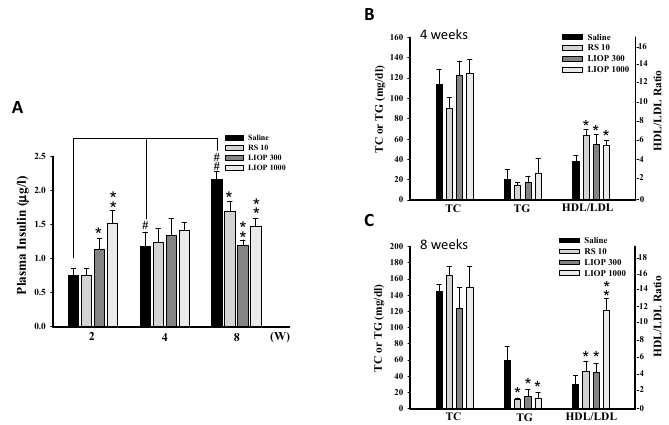
Figure 4. Plasma insulin levels and serum lipid profile. Blood samples were collected from the retro-orbital sinus of C57BL/6 mice with HFD + STZ-induced diabetic nephropathy. The plasma insulin levels were measured by ELISA at two, four, and eight weeks ( A ) and the plasma triglyceride (TG), total cholesterol (TC) and HDL/LDL ratio, respectively, were determined by the biochemistry analyzers at four and eight weeks. The modulation of plasma glucose and lipid metabolism were measured following LIOP (300 and 1000 mg/kg) and rosiglitazone (10 mg/kg) treatment as compared to the effects of the saline-alone group at four ( B ) and eight weeks ( C ). The data are expressed as mean ± SE of eight mice. *: p < 0.05, **: p < 0.01 as compared with the saline group at two, four, eight weeks. #: p < 0.05, ##: p < 0.01 compared with saline group at the two-week trial. Normal: native control; Saline: vehicle control; RS: rosiglitazone; LIOP: Low-molecular-weight, 10–100 kDa polysaccharides from Inonotus obliquus extract.